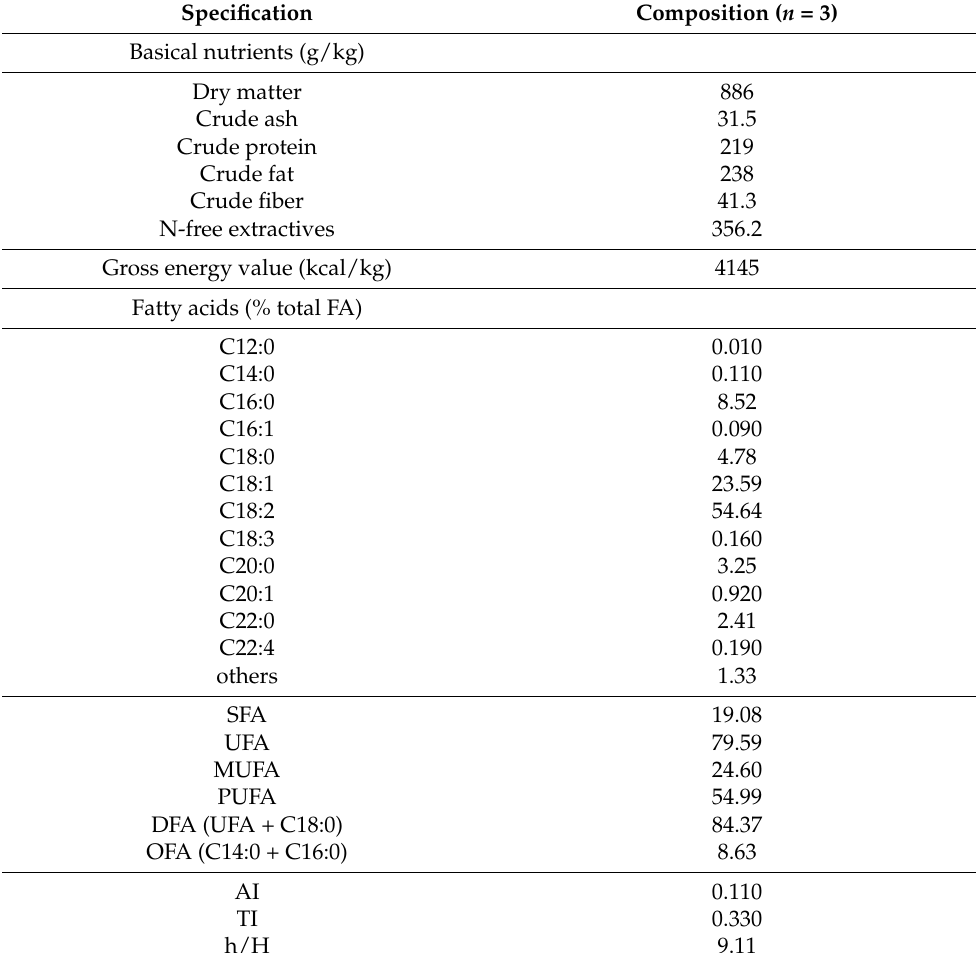
Table 2. Basic nutrients, energy value and fatty acids profile of milk thistle